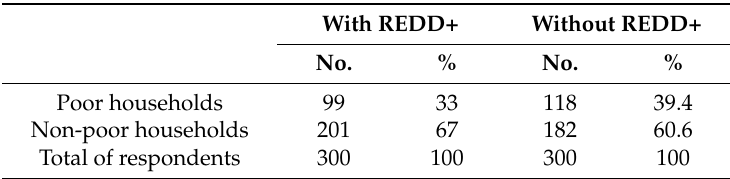
Table 11. Contribution of REDD+ to the poverty rate reduction of 300 respondents in Con Cuong District, Nghe An Province, 2016. With